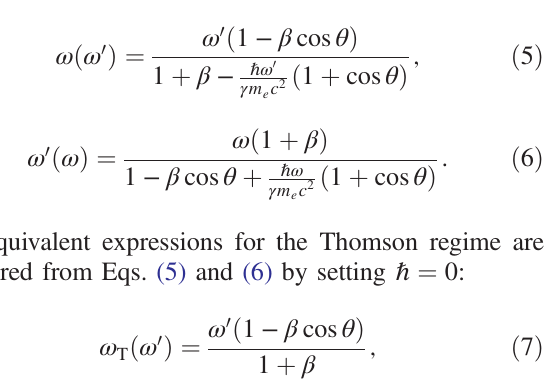
ffiffiffiffiffiffiffiffiffiffiffiffi 1 þ X